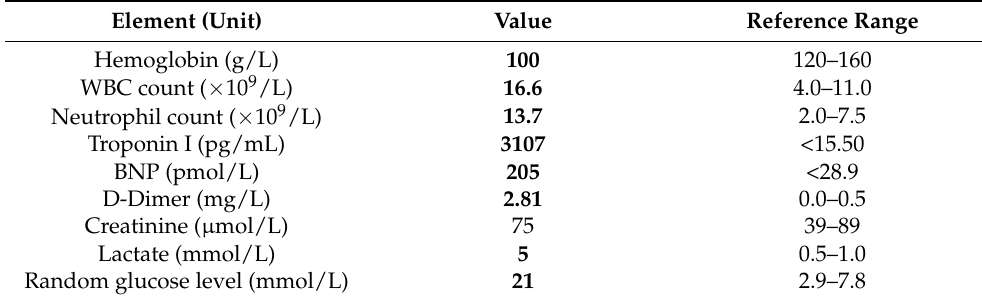
Figure 2. Posteroanterior chest X-ray (CXR) of the second case. The CXR demonstrates nodular changes mainly in the right lung and upper lobe of the left associated with cystic space/cavity in the upper lobe of the right lung. In addition, ill-defined consolidation with air bronchogram in the lower lobe of the right lung could be related to COVID-19. If positive otherwise, TB could not be ruled out. The cardiothoracic ratio is normal, and bilateral costophrenic angles are free with no obvious pleural effusion. Table 2. Summary of the laboratory investigations of the second patient.